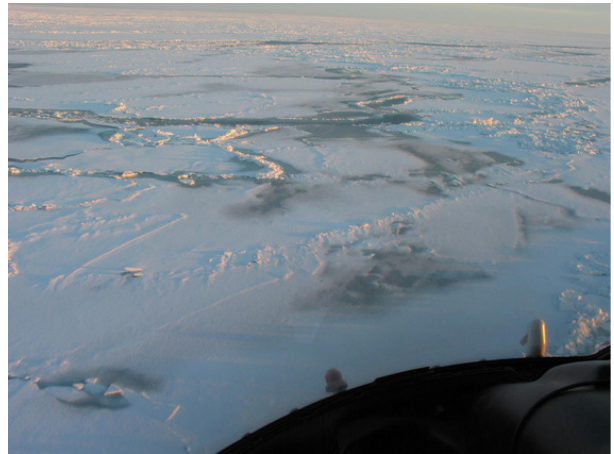
Fig. 4. Melted surface on the flight of 13 March 2007. Photograph courtesy of Juha Karvonen (FIMR).